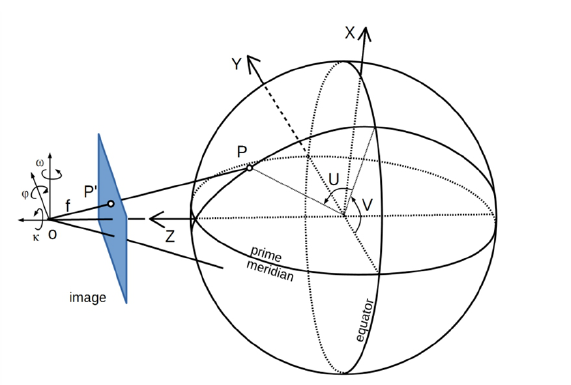
Figure 4. Scheme of photographing the